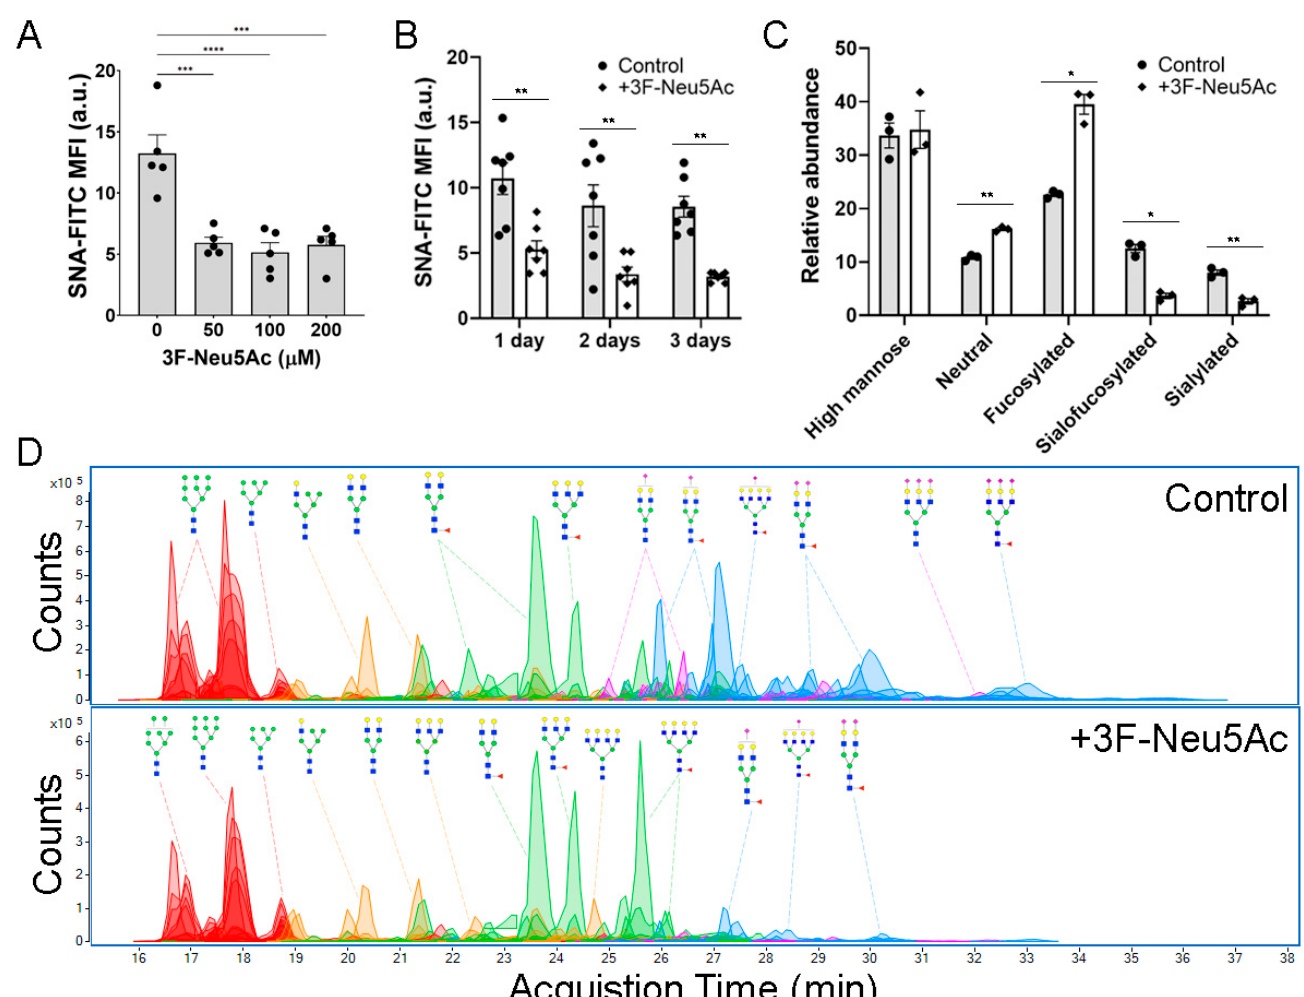
Figure 2. 3F-Neu5Ac effectively inhibits sialylation of N-glycans. ( A ) MSCs were cultured for 1 day with varying concentrations of 3F-Neu5Ac and analyzed by flow cytometry using the lectin SNA (n = 5). ( B ) Similarly, MSCs were cultured in the presence of 3F-Neu5Ac (50 µ M) for varying amounts of time, prior to analysis by flow cytometry (n = 7). ( C ) MSCs were cultured for 48 h with or without 3F-Neu5Ac (50 µ M) and subjected to mass spectrometry to evaluate the impact on different N-glycoforms (n = 3). ( D ) Representative chromatograms of MSCs treated with or without 3F-Neu5Ac, where red peaks show high mannose N-glycans, yellow peaks are neutral N-glycans, green peaks are fucosylated N-glycans, blue peaks are sialofucosylated N-glycans, and purple peaks are sialylated N-glycans. * p < 0.05; ** p < 0.005; *** p < 0.0005; and **** p <